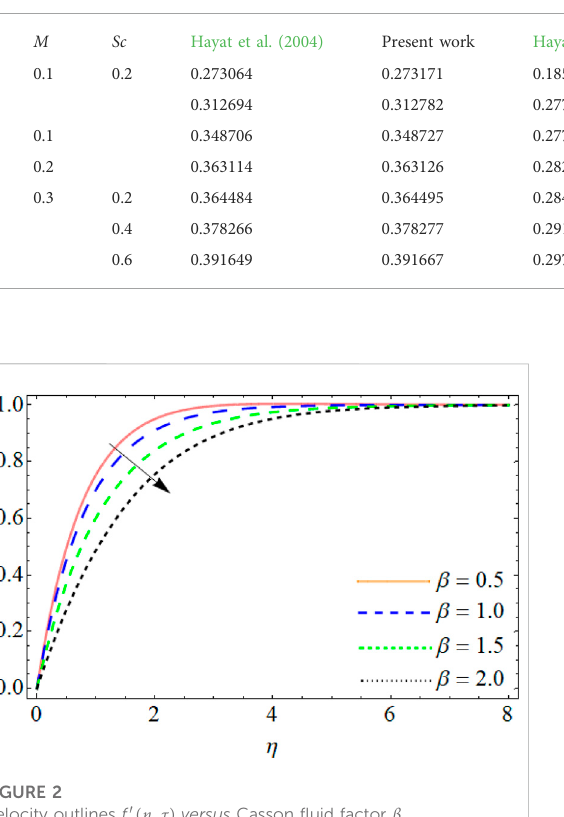
TABLE 1 Comparison of the present outcomes with published work for skin friction, Nusselt and Sherwood numbers, where β (cid:2) Gr (cid:2) 0. Parameters